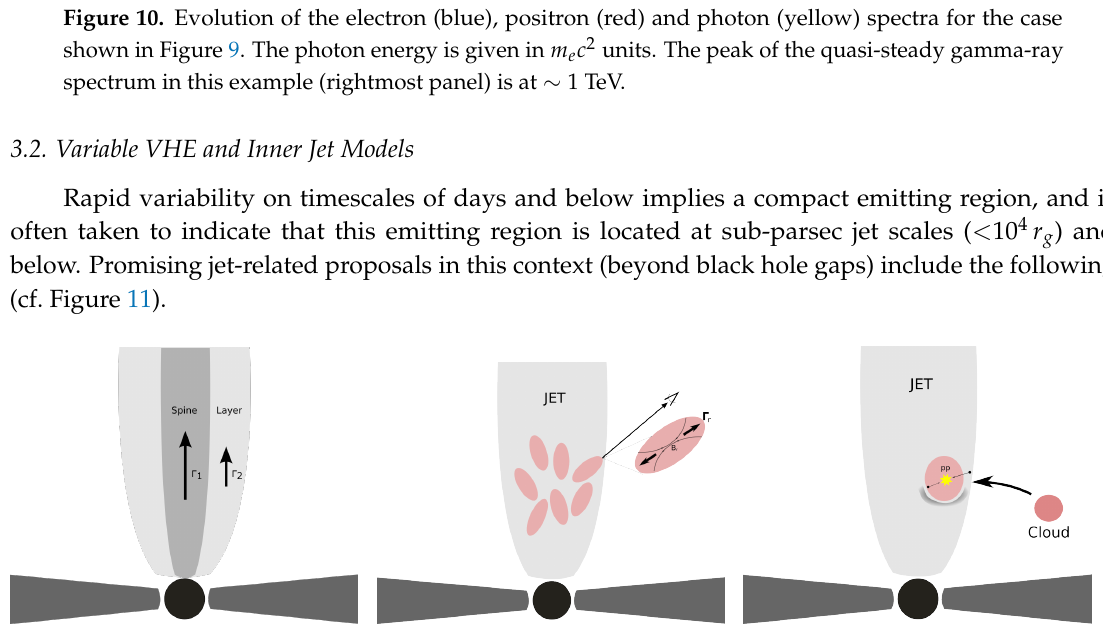
Figure 11. Possible scenarios for the origin of rapidly variable VHE emission on scales of the inner jet, i.e., beyond black hole magnetospheric emission. Left: Illustration of a stratified jet composed of a fast spine - slow layer [93]. Radiative interplay (external IC) can increase the γ -ray luminosity of each component. Middle: Illustration of a jets-in-jet model [94], where a variety of ’mini-jet’ features (plasmoids) are triggered by magnetic reconnection events within the main jet flow. This could lead to an additional velocity component relative to the main flow ( Γ r ) and allow a favorable orientation with respect to the observer. Right: Illustration of a hadronic model, where interactions of the jet with a massive obstacle (star or cloud) facilitates shock-acceleration and introduces a sufficient target density to allow for efficient pp -collisions